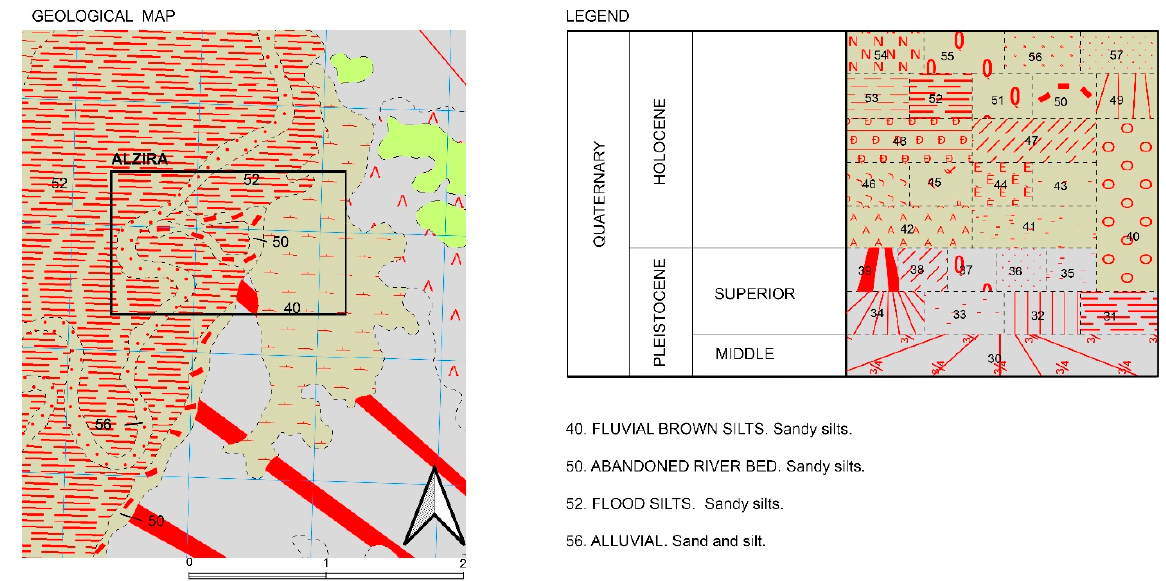
Figure 3. Geological map of Spain scale 1/50,000 MAGNA.Sheet 770 (Alzira) and legend. Source: IGME: http://info.igme.es/cartografiadigital/geologica/Magna50Hoja.aspx?intranet=false&id=77 (accessed on 30 May 2020).